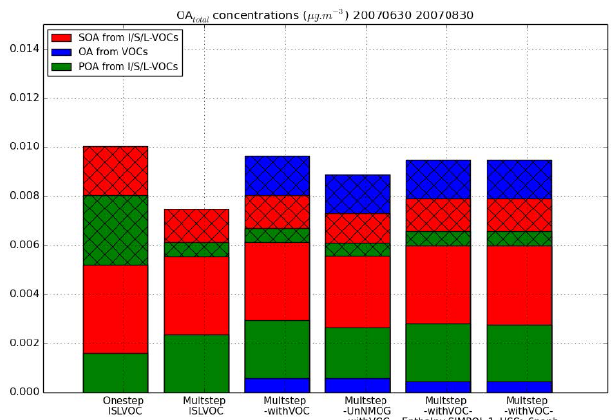
Figure 10. Mean surface OA tot concentrations from different OA tot precursors over the subregion for each sensitivity simulation. The cross-hatched part corresponds to OA concentrations in the gaseous phase, while the plain parts correspond to OA concentrations in the particle